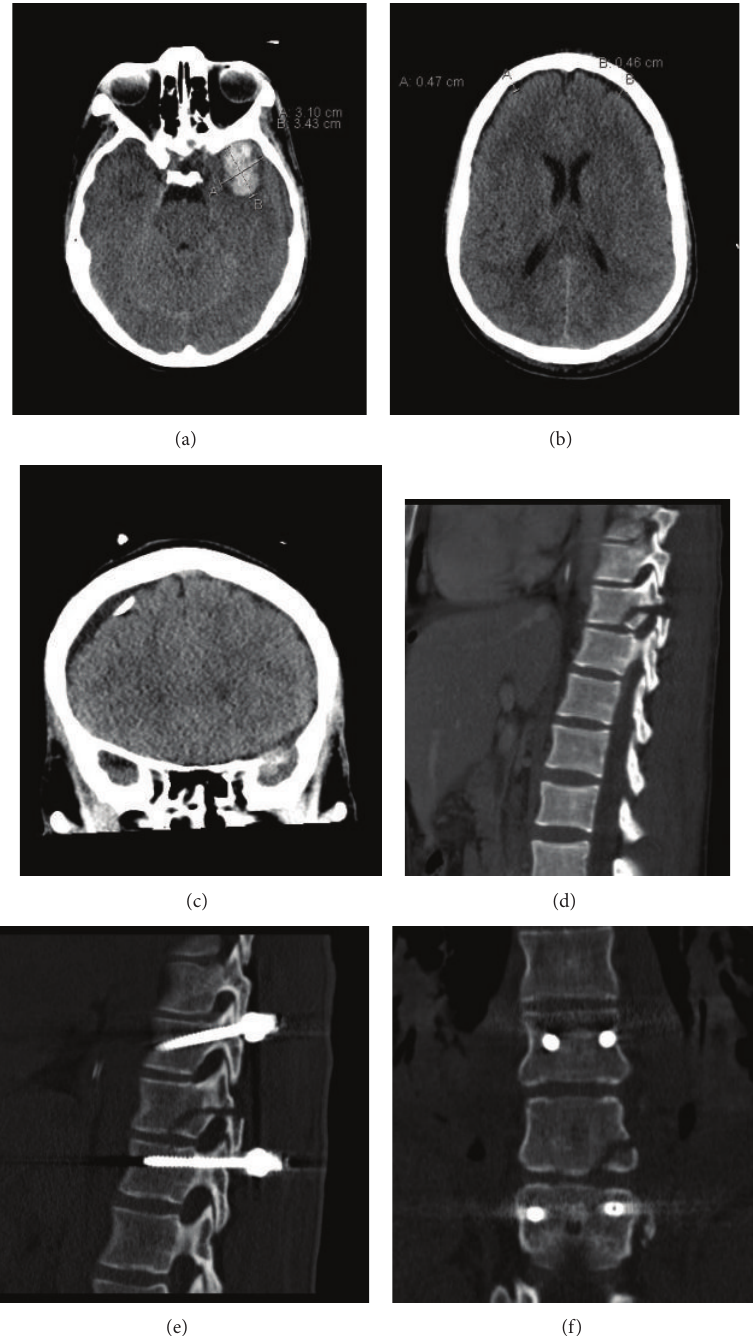
Figure 3: Radiologic evaluation of the intracranial and spinal injuries: (a) and (b) computertomographic imaging of the intracranial bleeding in the horizontal plane; (c) computertomographic control of the intracranial pressure probe; (d) sagittal imaging of the spine with unstable fracture of the 10th thoracic vertebra; (e) and (f) postoperative computertomographic control after dorsal instrumentation of the spinal